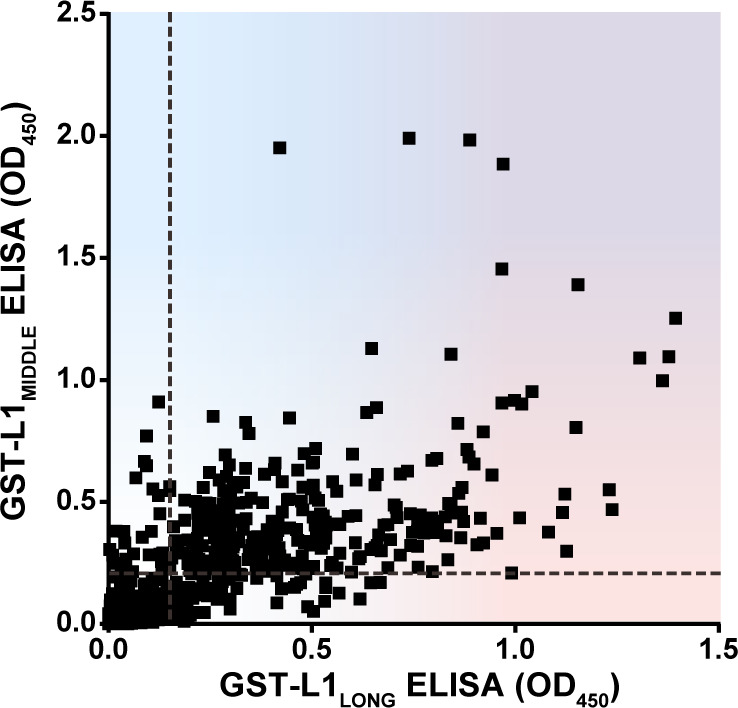
Additional correlation of seroreactivities measured by GST-ELISA.Correlation of seroreactivities against GST-L1LONG with seroreactivities against GST-L1MIDDLE (correlation coefficient, R2 = 0.4723).